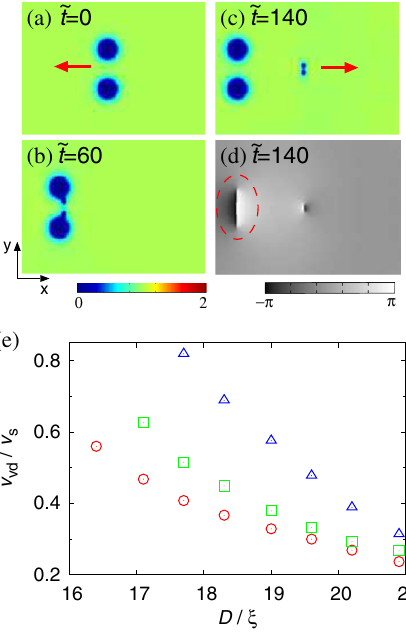
FIG. 7. (a)–(e) Dynamics of the density j ~ c j 2 ¼ j c j 2 =n files for the potential in Eq. (9) with V 0 : 6 , d=(cid:2) ¼ 4 : 5 , and D=(cid:2) ¼ 31 : 6 in the frame comoving with the potential. The field of view is 160 (cid:2) (cid:5) 67 (cid:2) . (f) The phase profile (cid:7) ¼ arg c of the region in the dashed square in (e). (See also Supplemental Material [31].)